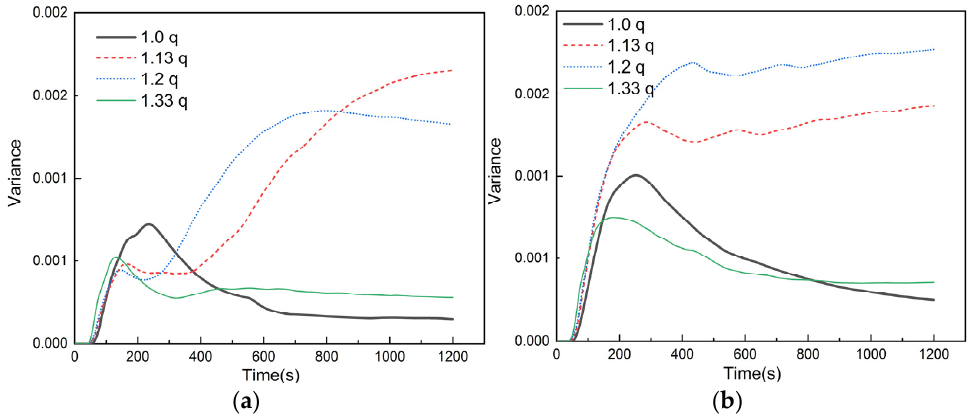
Figure 20. Variance of outflow percentage of the u-shaped weir tundish with uniform increasing casting flow rate under single-strand blockage conditions: ( a ) strand 1 blockage, ( b ) strand 2 block-